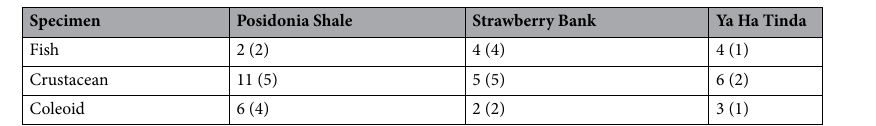
Table 1. Number of specimens analyzed (number in parentheses indicates the number of specimens figured in the